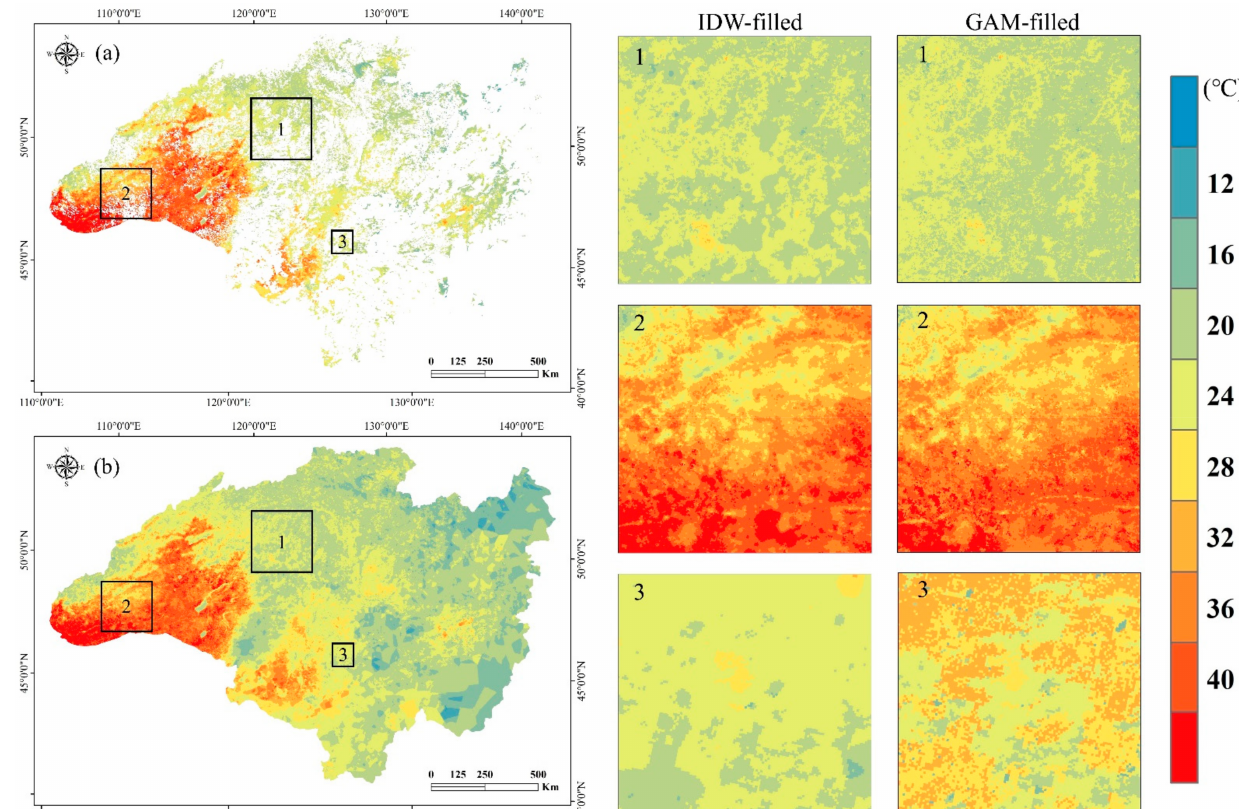
Figure 12. Comparison of the GAM-filled LST and the IDW-interpreted LST on DOY 185 (4 July 2010). The original MODIS LST is in ( a ) and the IDW-interpreted LST is in ( b ). The three subsets, forest (1), grassland (2), and agricultural land (3), reveal the visual differences between the two